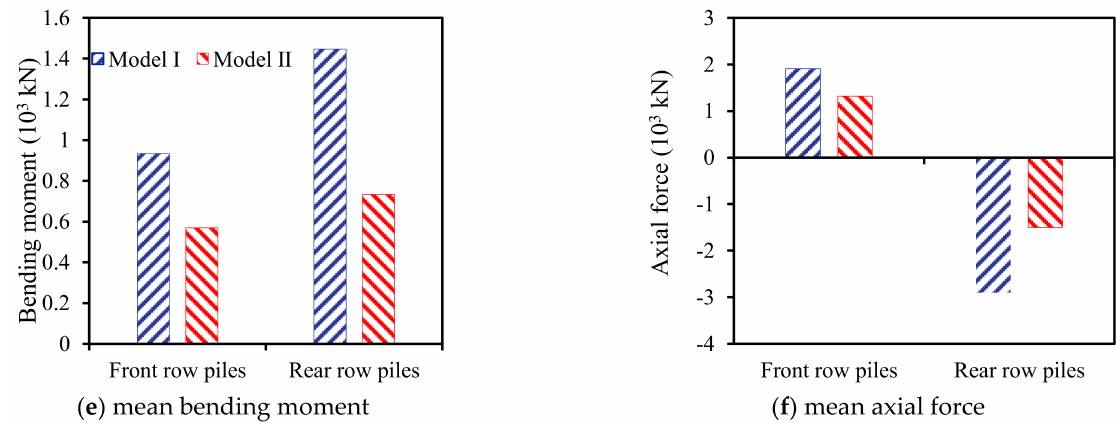
Figure 13. Bending moment and axial force response.